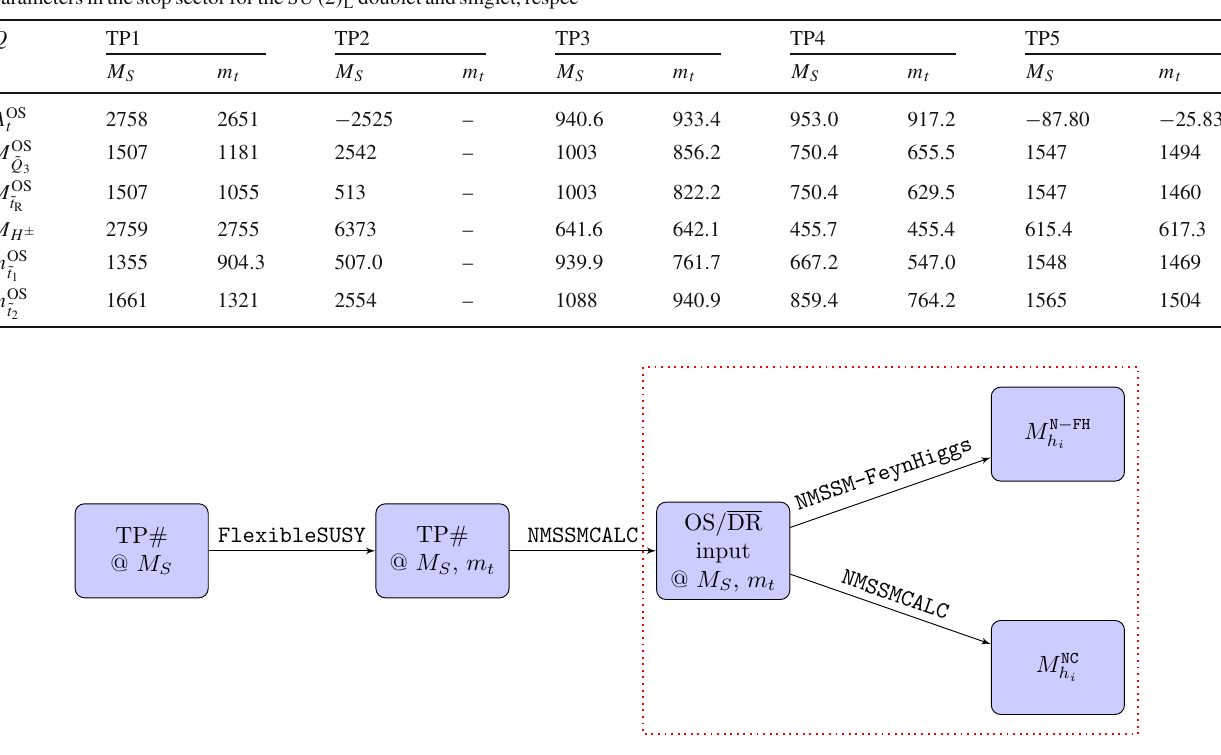
tively. M H ± denotes the OS renormalized mass of the charged Higgs boson, and m OS ˜ denotes the obtained OS masses of the two top squarks. t i All parameter values are given in